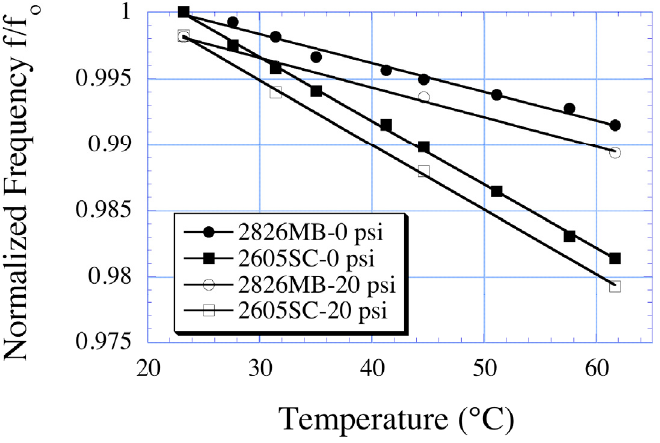
Figure 17. The normalized resonant frequency of a 2826MB alloy sensor, and a 2605SC alloy sensor, as a function of temperature at two different pressures. Both sensors are slightly curved, and hence demonstrate a similar, modest change in frequency with pressure. Reprinted with permission from